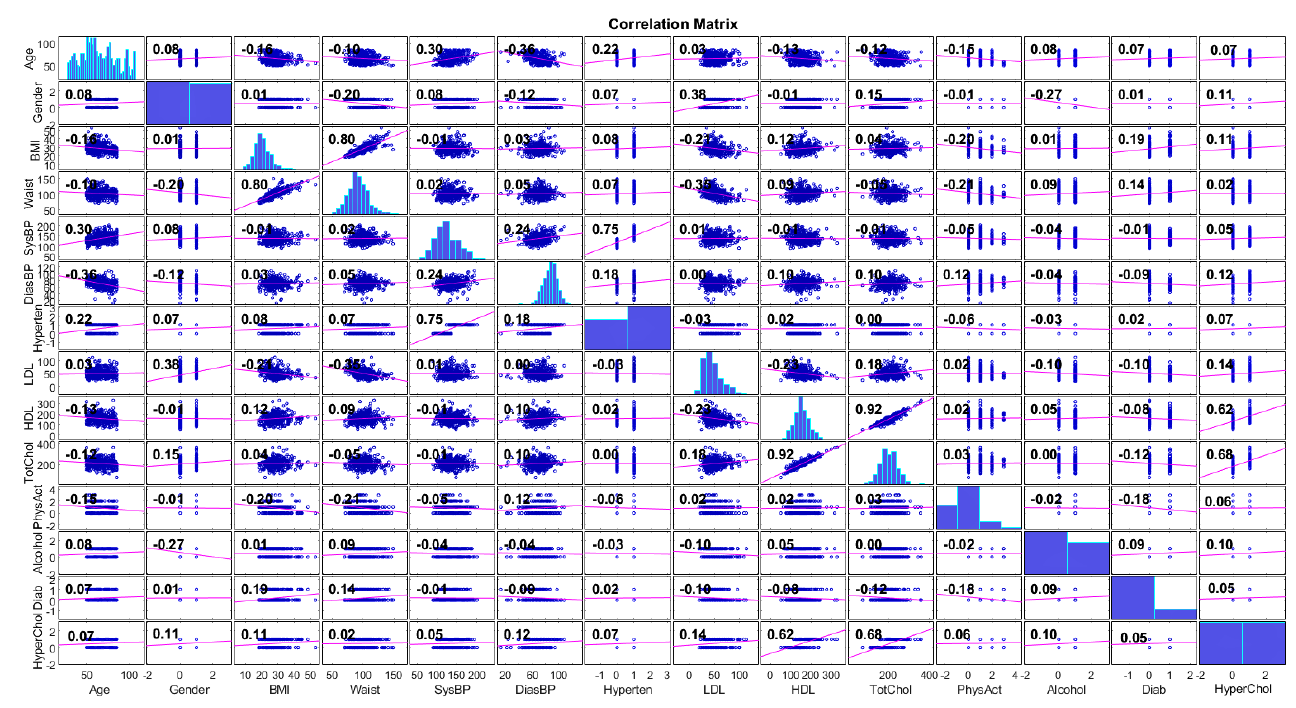
Figure 1. Pearson correlation